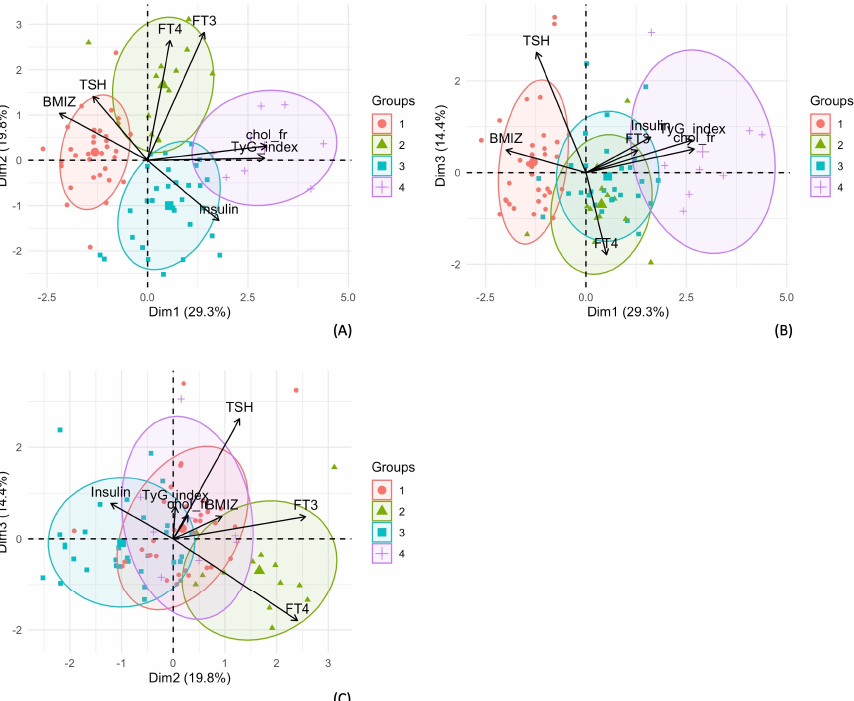
Figure 2. In this panel, the three subfigures show the profiles of each cluster found with HC. These are projected in the planes defined by the first three principal components. In ( A ) cluster one (red), is characterized by high values of PC1, namely, high values of BMI-z-score and high values of TSH. This is opposed to cluster four (purple) that is characterized by the lowest value of PC1, so by high values of total cholesterol to HDL cholesterol ratio (chol_fr) and triglycerides to glucose index (TyG-index). Moreover, cluster two is characterized by high values of PC2, namely, higher values of FT4 and FT3, while cluster three is opposed to two as is characterized by low values of PC2. In ( B ) and ( C ) the separation of the cluster by PC1 and PC2 is shown. Cluster one and four are distinguished by PC1, whereas cluster two and three are distinguished by PC2.